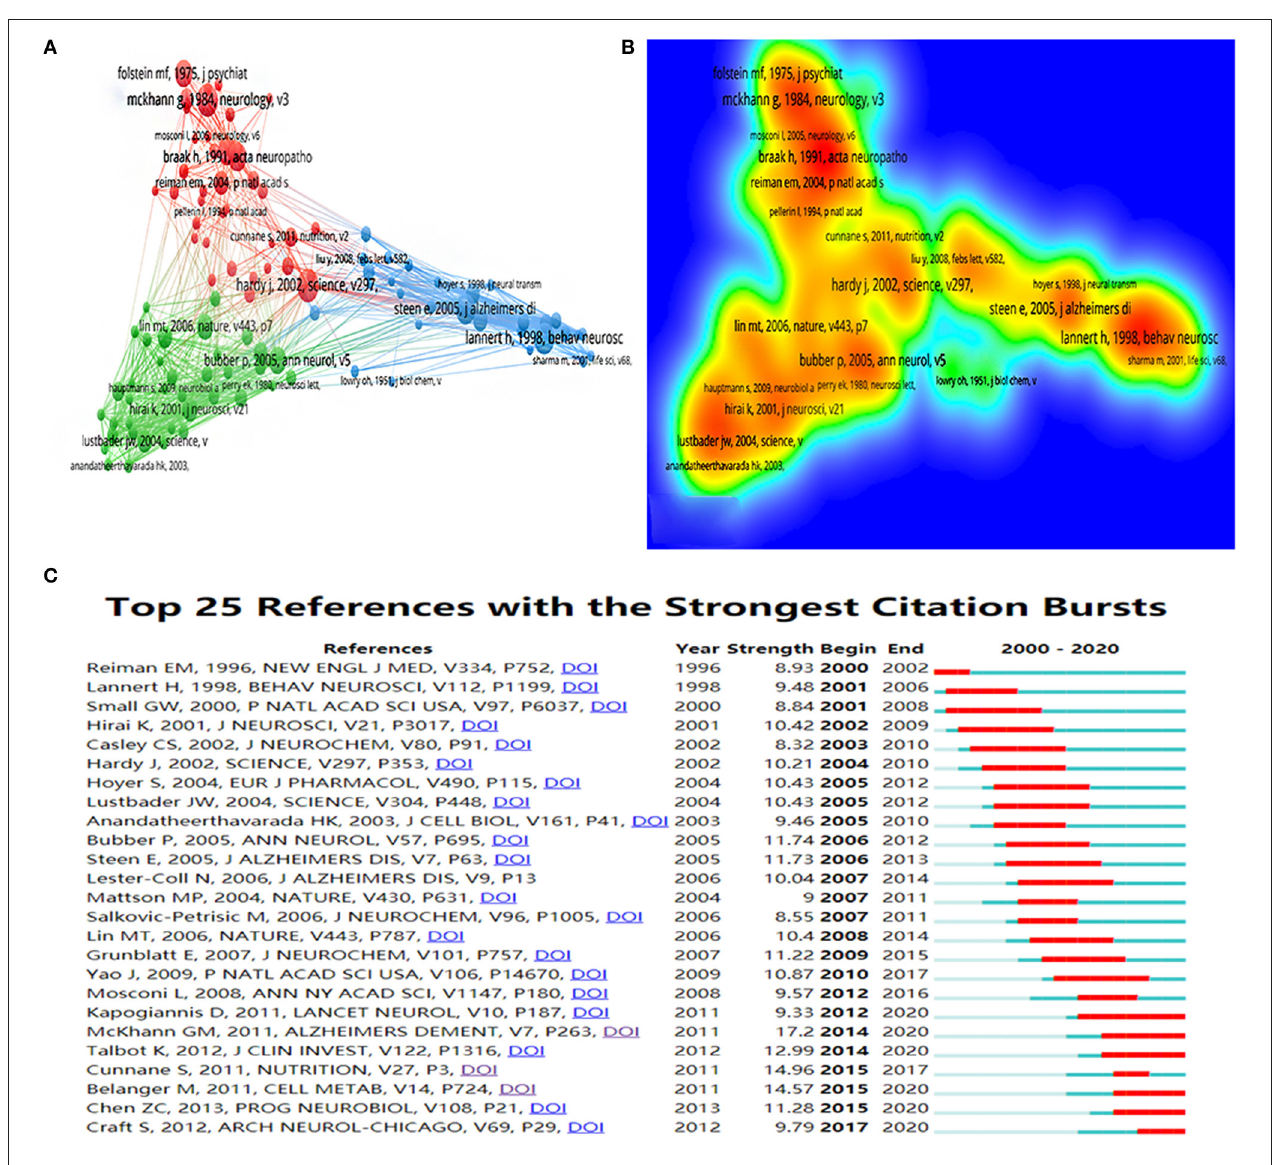
FIGURE 6 | (A) The co-citation network visualization map of references based on VOSviewer; (B) The density visualization map of references based on VOSviewer; (C) Top 25 references with the strongest citation bursts based on CiteSpace, The red horizontal stripes represent the years with the most frequent publications. The green horizontal stripes represent the years with the most infrequent